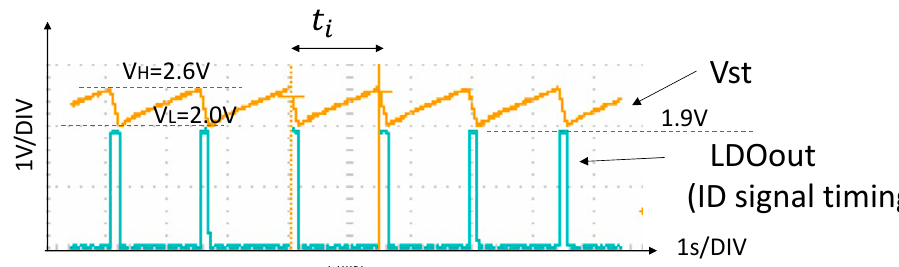
Figure 1. Circuit Structure of the DC Current Beat Sensor node.